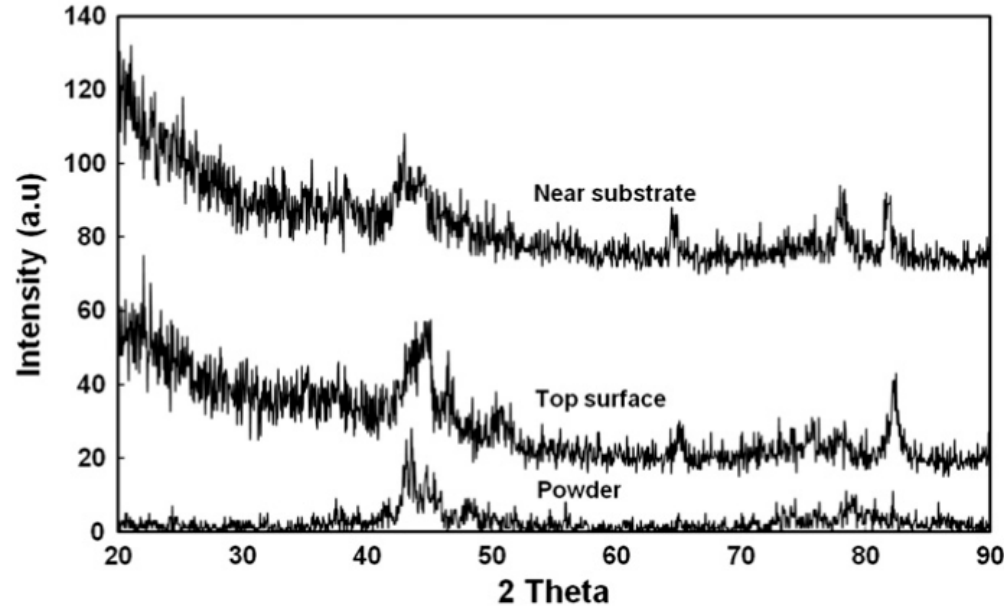
Figure 16. XRD patterns of the top surface (15 mm for substrate) and near substrate (0.8 mm from substrate) of LENS processed Fe-based BMGs compared to NSSHS7574 starting powder, illustrating that the amorphous alloys have a mixture of amorphous and crystalline phases (reprinted with the permission from [80], Elsevier, 2010).